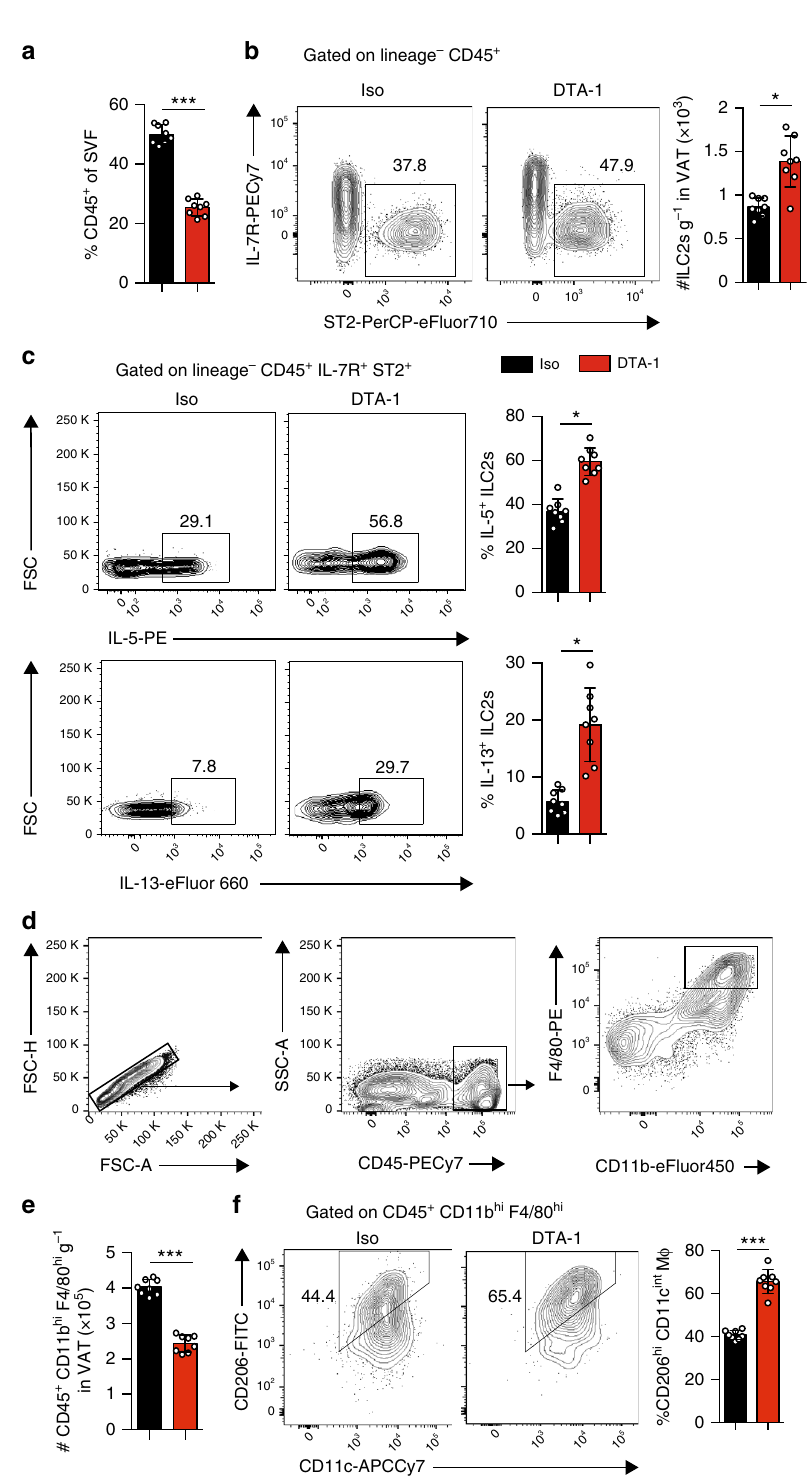
Fig. 4 GITR engagement drives ILC2-derived secretion and M2 macrophage polarization. A cohort of Rag2 -/- mice were fed on HFD and either treated with DTA-1 (1 mg/mouse) or isotype control by intraperitoneal injection every four days, n = 8. a The frequency of CD45 + cells of the VAT stromal vascular fraction (SVF) was quanti fi ed by fl ow cytometry. b Representative fl ow cytometry plots of VAT Lin - CD45 + IL-7R + ST2 + ILC2s in each group after 14 weeks of treatment, and corresponding quantitation presented as the number of ILC2s per gram of VAT. c Representative fl ow cytometry plots of intracellular IL-5 (top panel) and IL-13 (bottom panel) in VAT ILC2s and corresponding quantitation after 14 weeks of treatment, presented as frequency of positive ILC2s. d Gating strategy of macrophages in mouse VAT as CD45 + CD11b hi F4/80 hi . e Quanti fi cation of the number of CD45 + CD11b hi F4/80 hi macrophages per gram of VAT. f Representative fl ow cytometry plots of CD45 + CD11b hi F4/80 hi CD206 + CD11c + M2 macrophages in VAT and corresponding quantitation after 14 weeks of treatment. Error bars are the mean ± SEM. Student ’ s t -test, * p < 0.05, *** p <